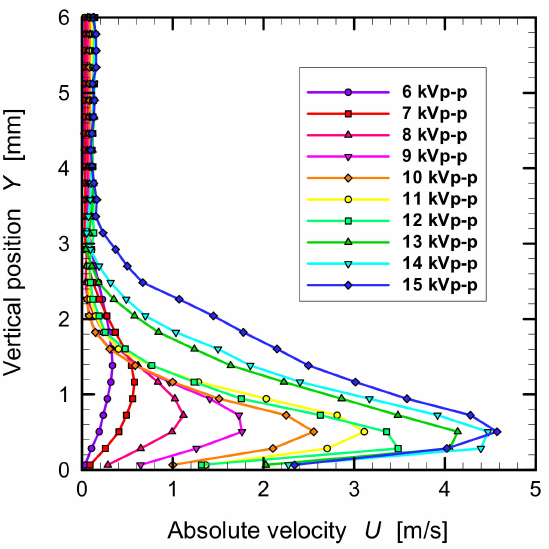
Figure 6. Vertical distributions of absolute velocity at streamwise position of Z = 8.5 mm.